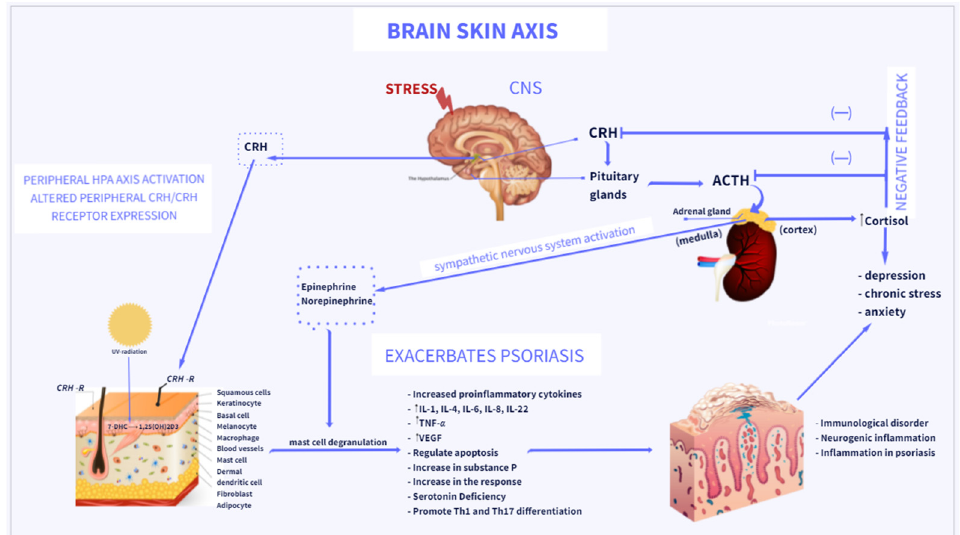
Figure 1. Brain–skin axis: association between psoriasis and depression. Stress acts via several pathways to exacerbate psoriasis, via the central and peripheral HPA axes, regulation of cytokine production, and activation of the sympathetic nervous system. The final messengers of the sympa- thetic nervous system and HPA, norepinephrine and cortisol, can directly engage in regulation of various immune cells to modulate immune responses. Direct action of CRH induces inflammatory responses in psoriasis. CRH and CRH-related peptides can be produced by several cells in the skin and stimulate the local production of cytokines in the skin. By binding to CRH-R on mast cells, CRH induces mast cell degranulation and releases proinflammatory factors, which induces further inflammation in psoriasis. The increase in cortisol levels causes the exacerbation of psoriasis and the activation of Th-17 cells, which leads to an increase in the levels of pro-inflammatory cytokines IL-17, TNF- α contributing to the development and intensification of depressive disorders. Vitamin D 3 (Vit D 3 ) is synthesized in the skin from its precursor 7-DHC under the influence of UVB and metabolized to its active form, 1,25(OH) 2 D 3 .